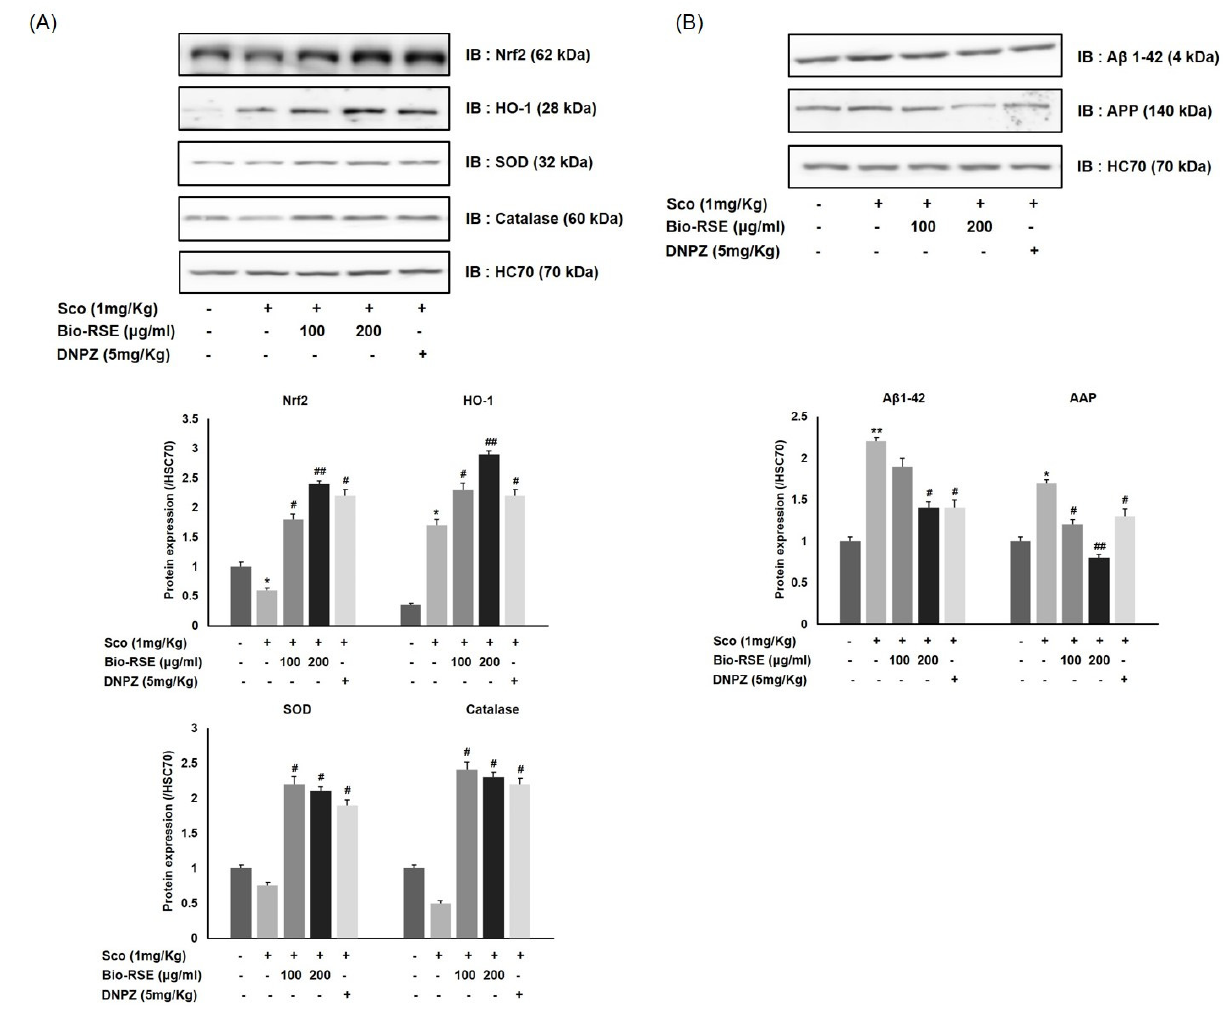
Figure 6. Effect of Bio ‐ RSE on Nrf2/HO ‐ 1 protein expression ( A ) and A β 1–42/AAP protein expres ‐ sion ( B ) in brain tissue. Normal—oral administration of drinking water + 0.9% NaCl i.p.; control—oral administration of drinking water + scopolamine 1 mg/kg i.p.; Bio ‐ RSE 100—oral administration of Bio ‐ RSE 100 mg/kg + scopolamine 1 mg/kg i.p.; Bio ‐ RSE 200—oral administration of Bio ‐ RSE 200 mg/kg + scopolamine 1 mg/kg i.p.; DNPZ—oral administration of donepezil 1 mg/kg + scopolamine 1 mg/kg i.p. * p < 0.05 and ** p < 0.01 when compared to the vehicle ‐ treated normal group; # p < 0.05 and ## p < 0.01 when compared to the scopolamine-treated control